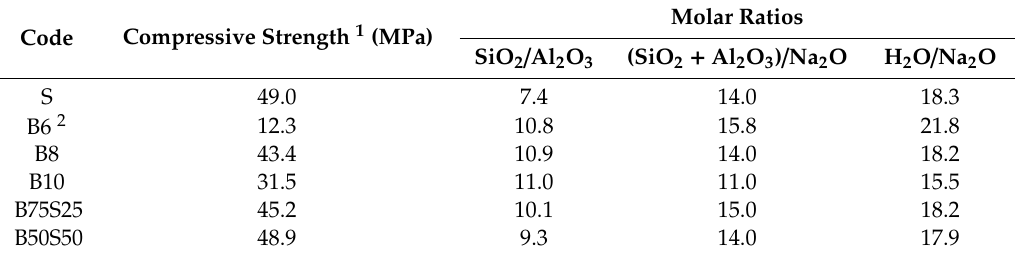
Table 3. The e ff ect of selected oxide molar ratios in the initial paste on the compressive strength of selected